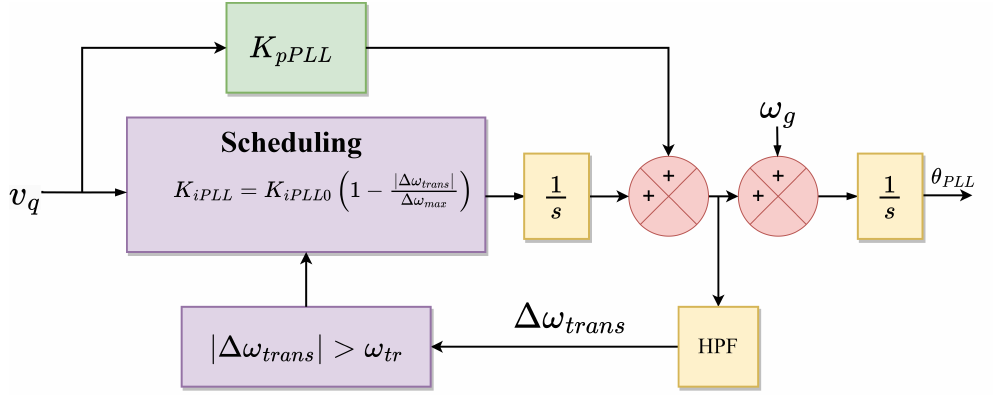
Figure 16. Approach 3 [112].